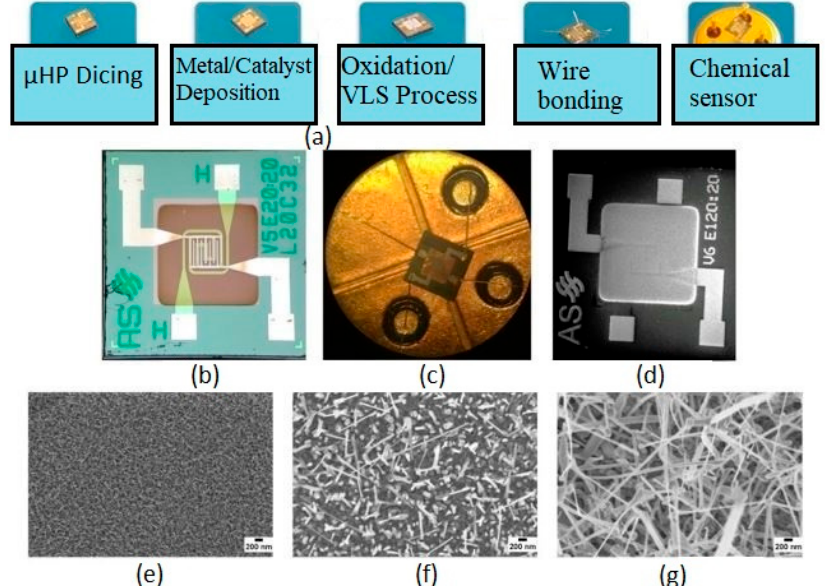
Figure 3. ( a ) Schematic diagram of the fabrication of the nanowires on the hotplates. ( b , c ) Optical images of the three types of nanowires. ( d ) Scanning Electronic Microscopic (SEM) image of the tin oxide-based sensor at low magnification. ( e – g ) SEM images of the tungsten trioxide, copper oxide and tin oxide nanowires, respectively [120].